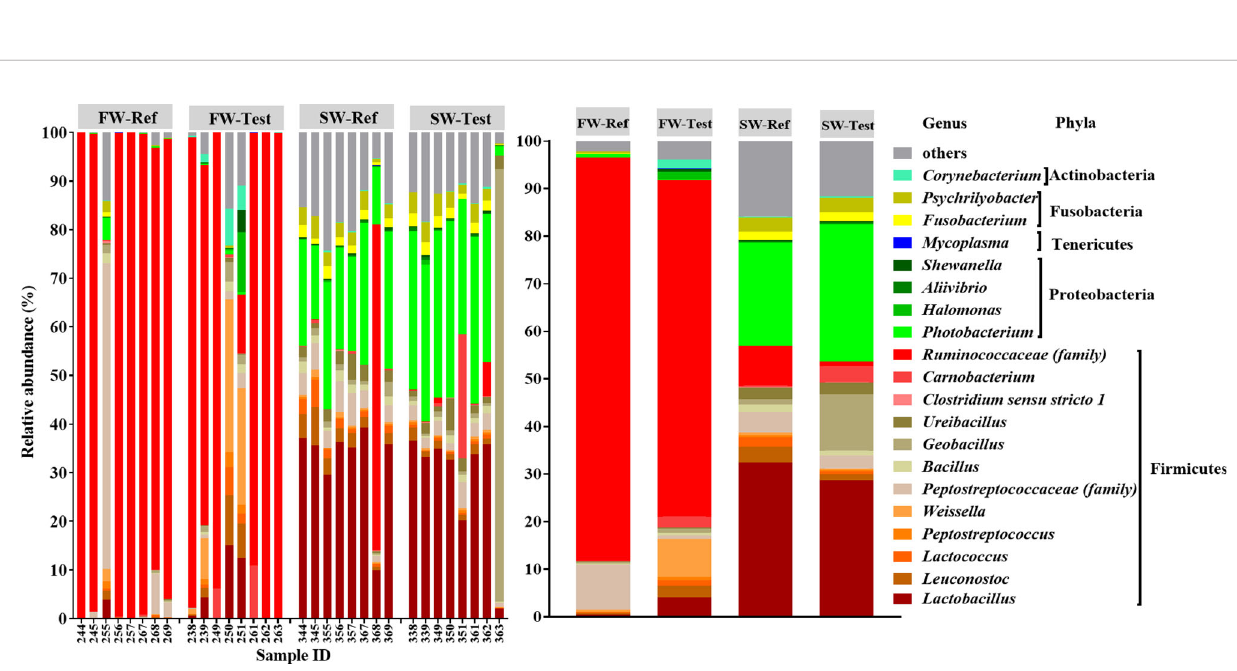
FIGURE 8 | Top 20 most abundant taxa of all samples at the genus level. The top 20 genera accounted for more than 80% of the total abundance in each treatment. The mean relative abundance of each taxon within the same treatment is displayed on the right side. f__,